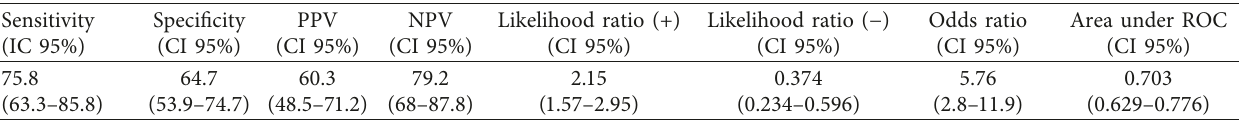
Table 4: Main diagnostic indicators of 2014 ICCRTC subclassification.